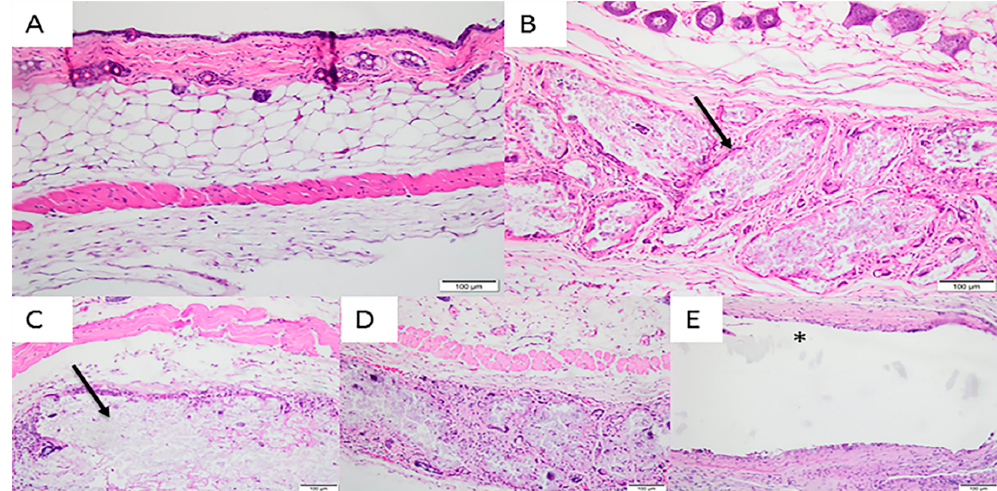
Figure 7. Photomicrographs of the experimental groups after 60 days of membrane implantation in the connective tissue. ( A ) Group 1 (Sham): discrete presence of lymphocytes, plasm cells and macrophages; ( B ) Group 2 (200 µm): moderate presence of lymphocytes, macrophages and multinucleated giant cells, a discrete presence of plasm cells and an absence of polymorphonuclear cells; ( C ) Group 3 (500 µm) and Group 4 (700µm): discrete/moderate presence of lymphocytes, macrophages, multinucleated giant cells and plasm cells; ( D ) and ( E ) Group 5 (Pratix®): absence of